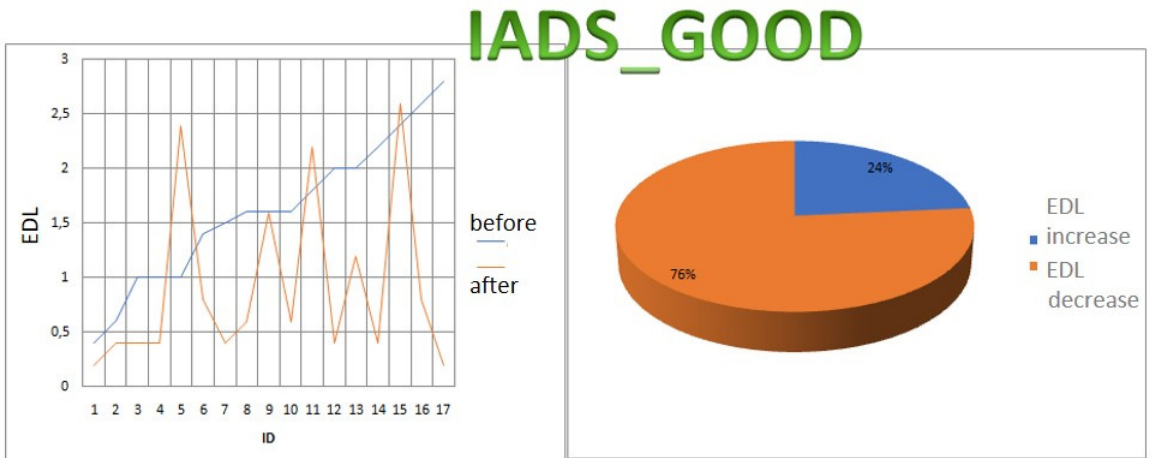
Figure 15. The mean values of the emotional disadaptation level (EDL Test) before and after positive stimulation.